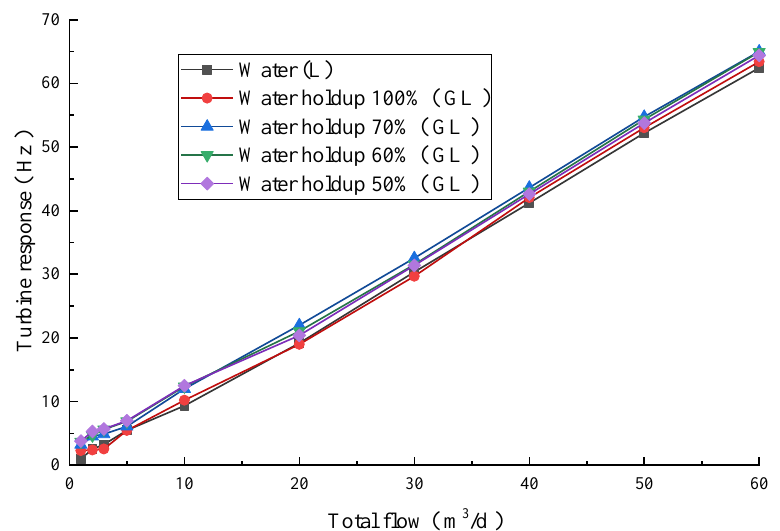
Figure 15. Response curve of the turbine flowmeter with different total liquid flow when gas flow rate is 10 m 3 /d.